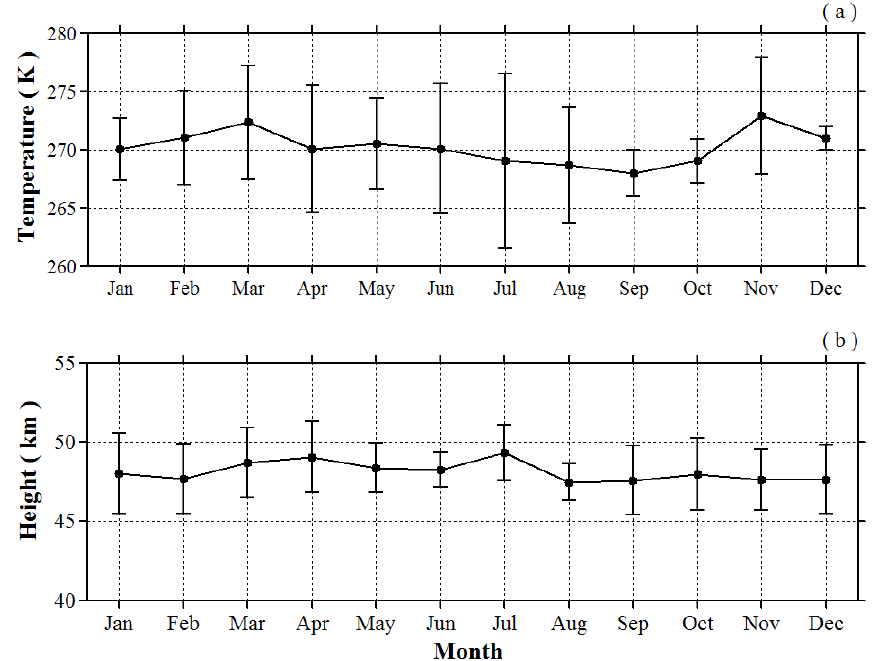
Fig. 4. Monthly climatological variations of (a) temperature and (b) height of stratopause over Reunion Island, with corresponding standard deviations obtained from LIDAR for the period from 1994 to 2007.